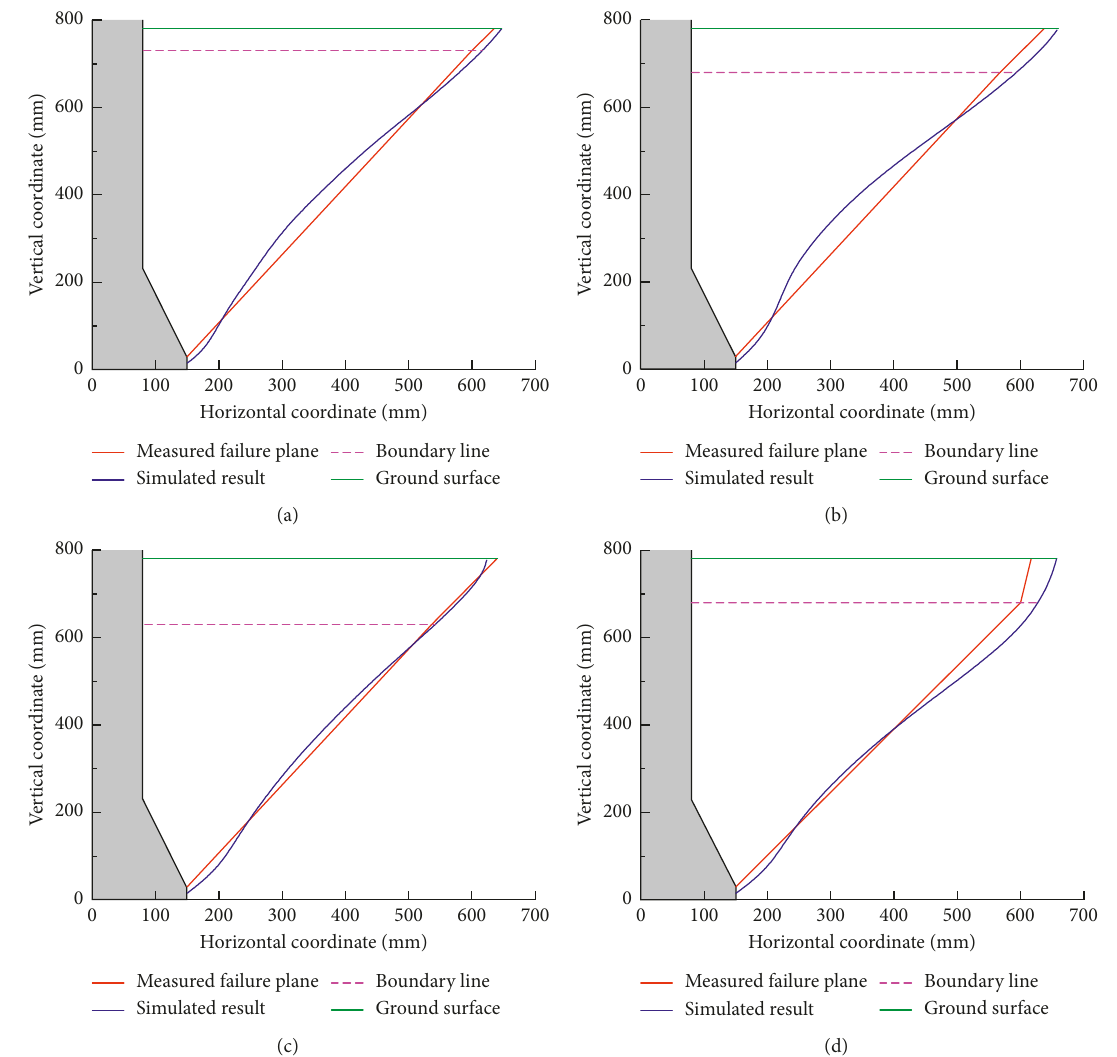
Figure 22: Comparison of calculated and measured failure plane. (a) Test I. (b) Test II. (c) Test III. (d) Test IV.